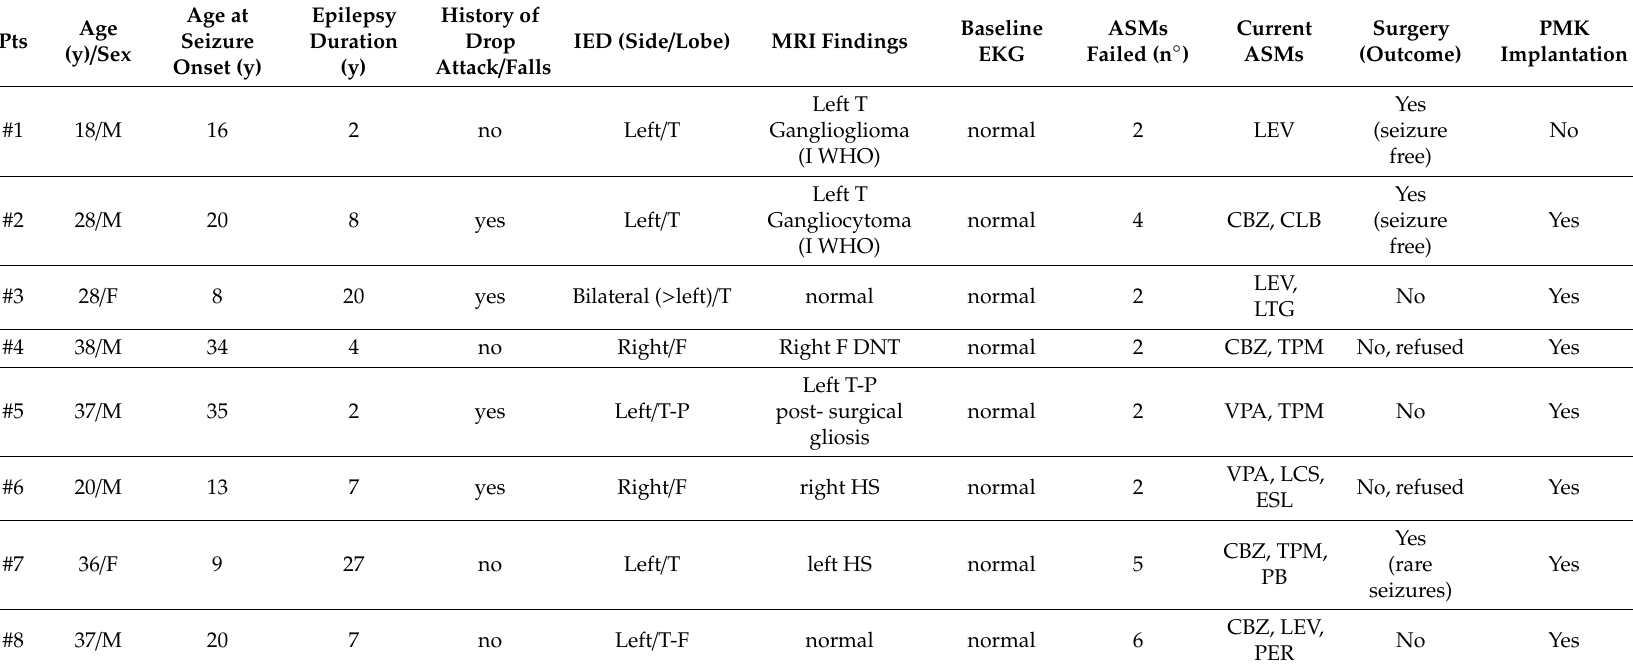
Table 1. Demographic and general patient’s